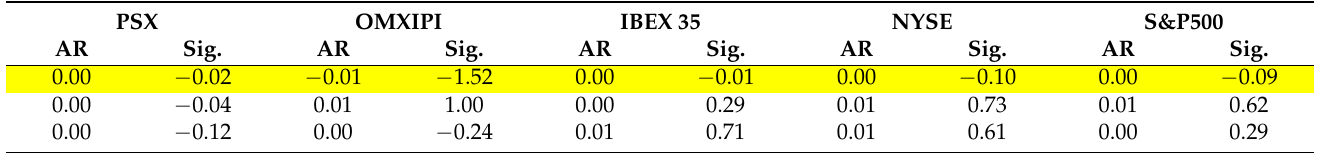
Table A36. Abnormal returns of the (0, +2) event window (Resignation of D. Jos é Manuel Soria, Spain’s Minister of